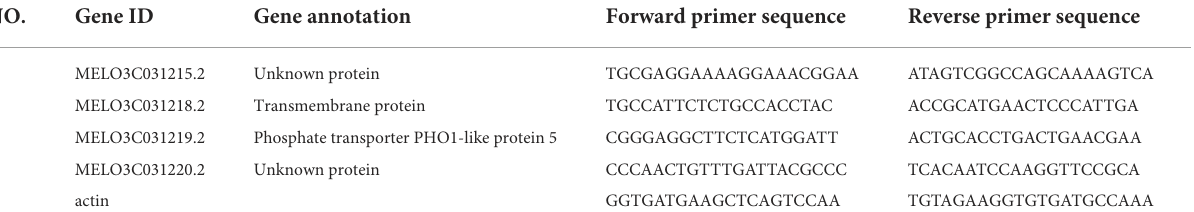
TABLE 5 Candidate gene sequencing and gene annotation for QTL qsg5.1 .